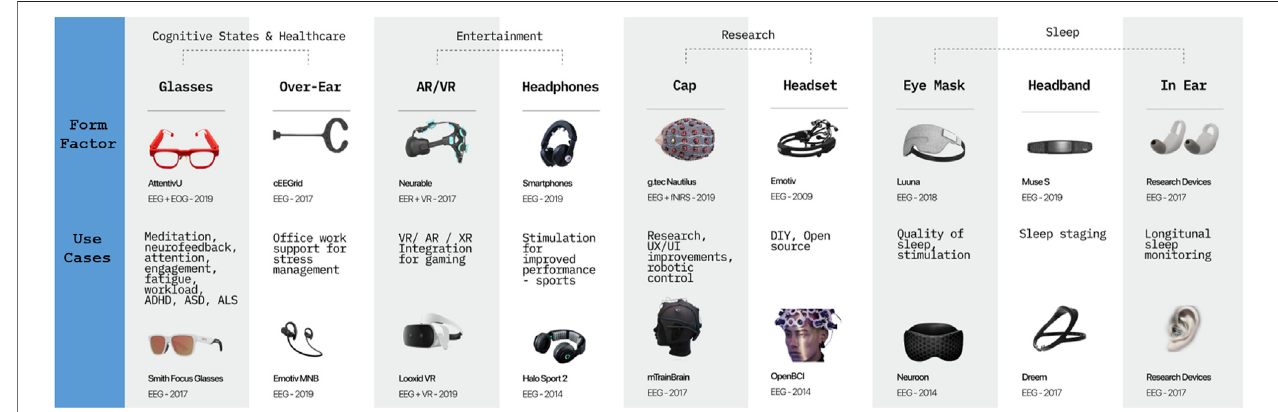
FIGURE2| Thestate-of-the-artinBrain-ComputerInterface(BCI)systemsdiscussedinSection5.1.The fi gurerepresentscurrentmostcommonform-factorsand use cases of BCI technology for the next 15 years.